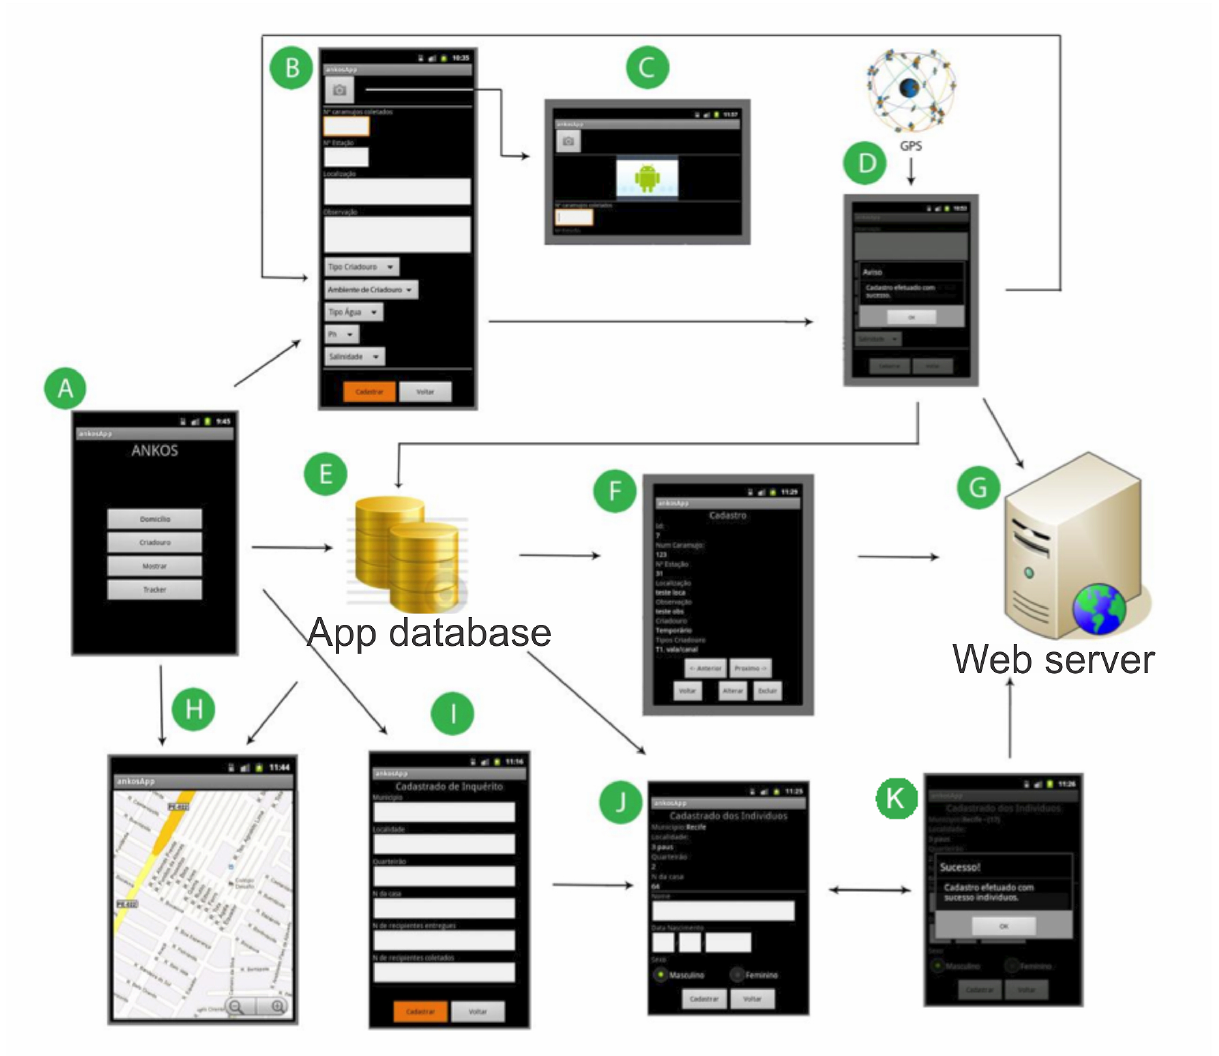
Figure 1. Initial version of the Schisto Track app. Global positioning system (GPS); Application (App); A New Kind of Simulator